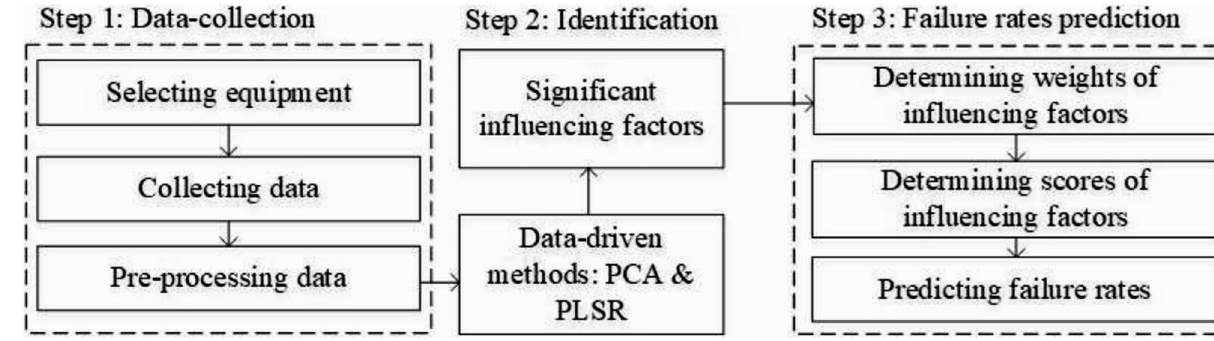
Fig. 5 Framework for predicting failure rates (Jani et al. 2019)